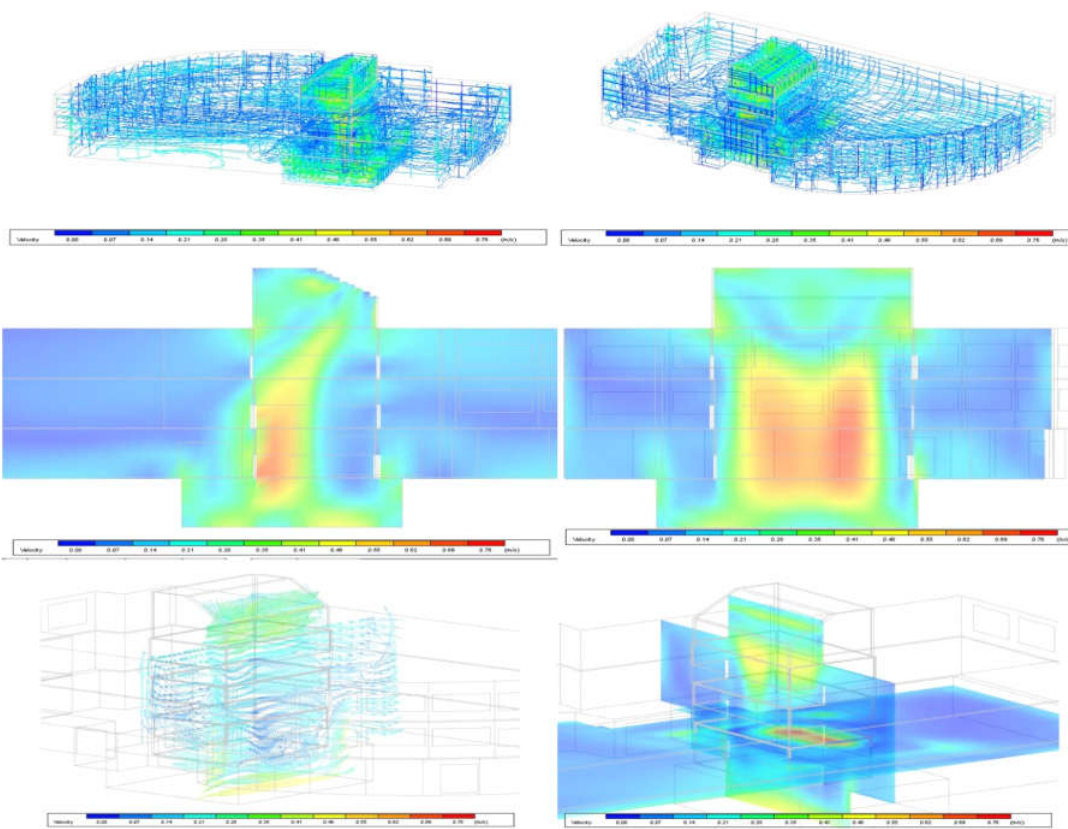
Fig. 4: CFD simulation results of proposed